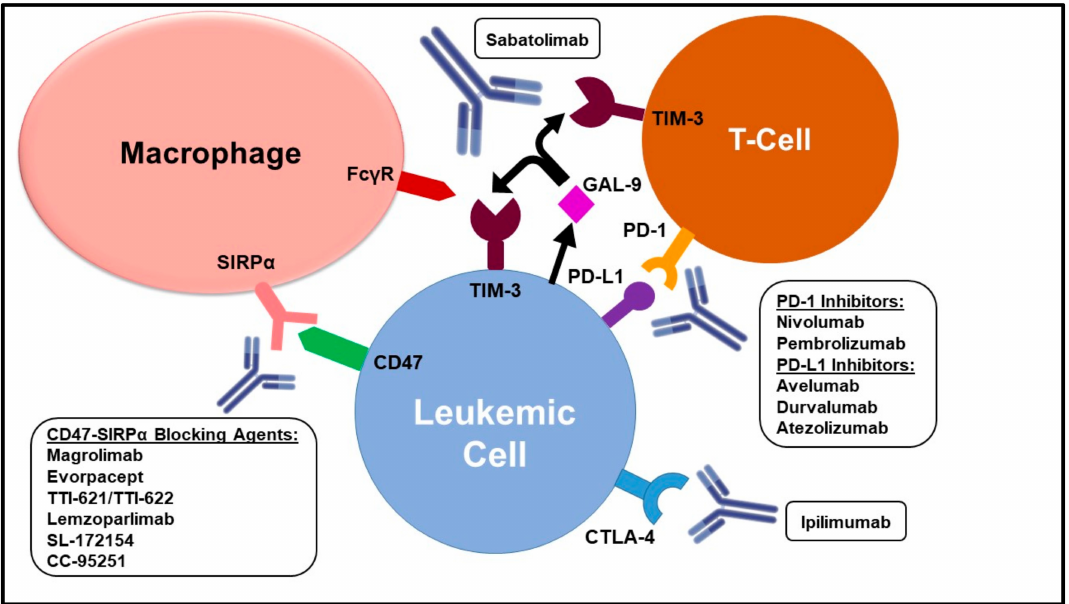
Figure 1. Main Mechanisms of Immune Evasion in Acute Myeloid Leukemia and Myelodysplastic Syndromes.